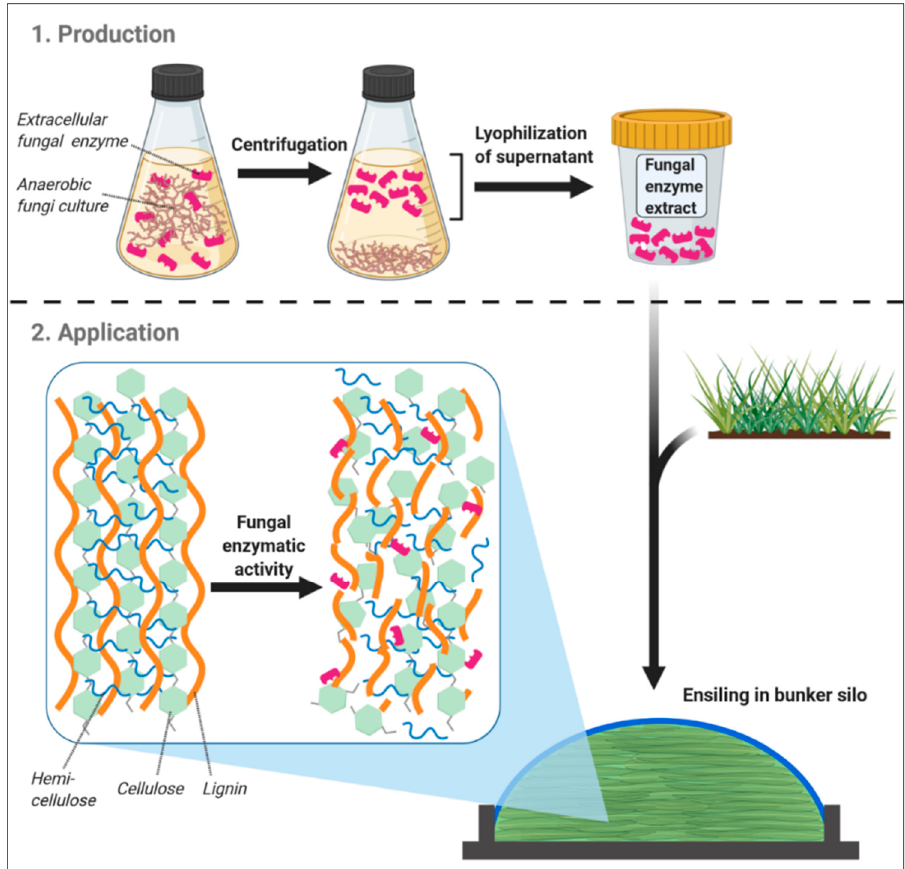
Figure 1. Basic scheme of the production and application of an anaerobic fungi-based silage additive, as well as its potential mode of action during ensiling. Created with BioRender.com.